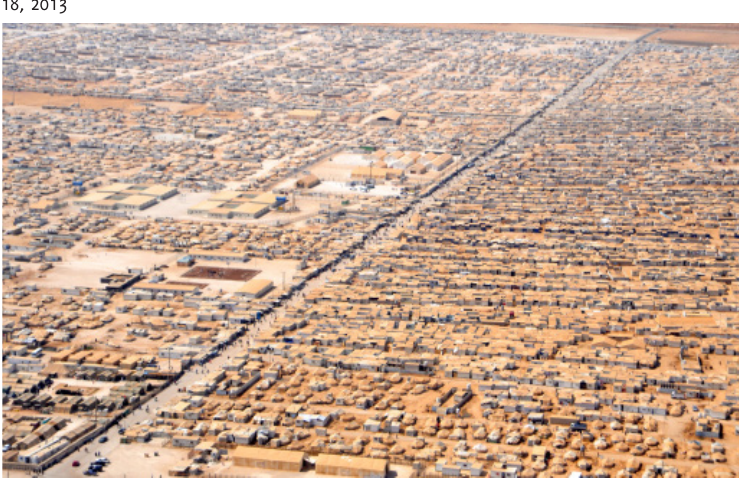
Figure 1. Zaatari Refugee Camp for Syrian Refugees in the North of Jordan as Seen on July 18, 2013